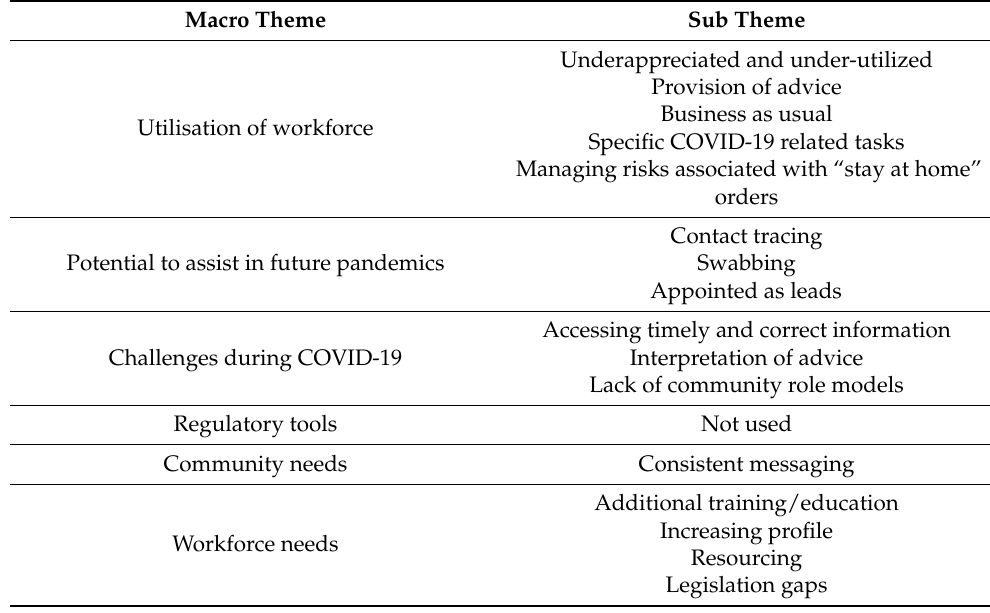
Table 3. Macro themes and associated